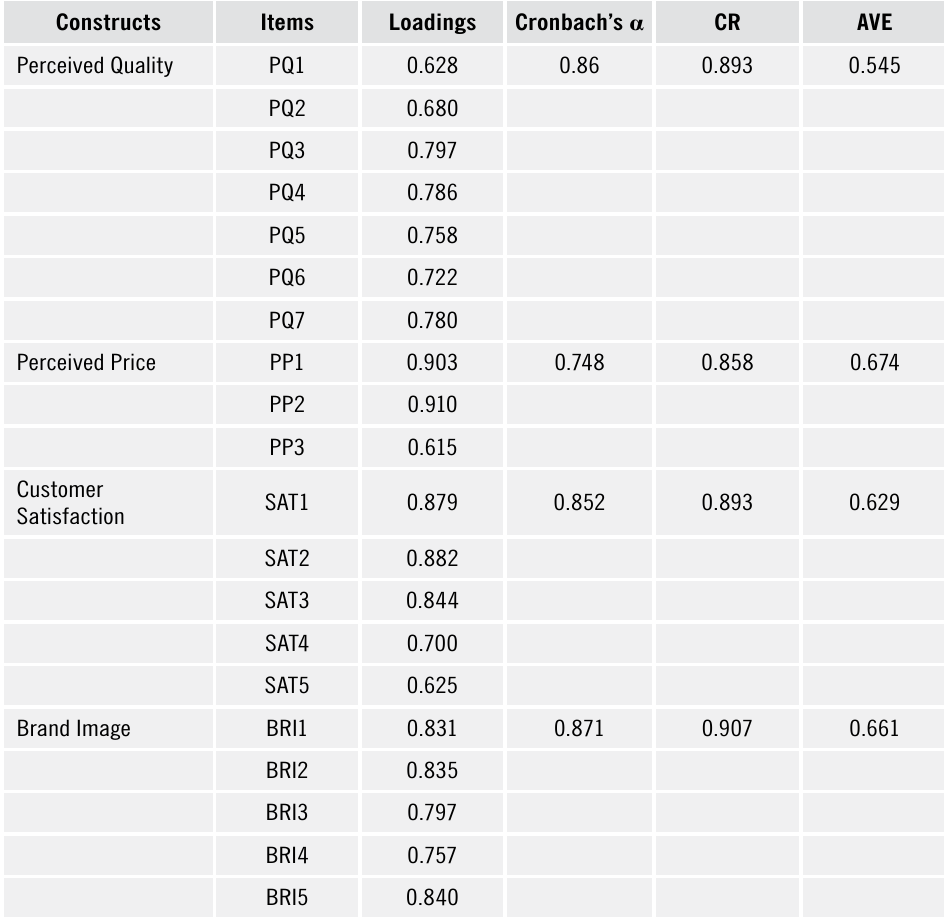
Table 3. Measurement model